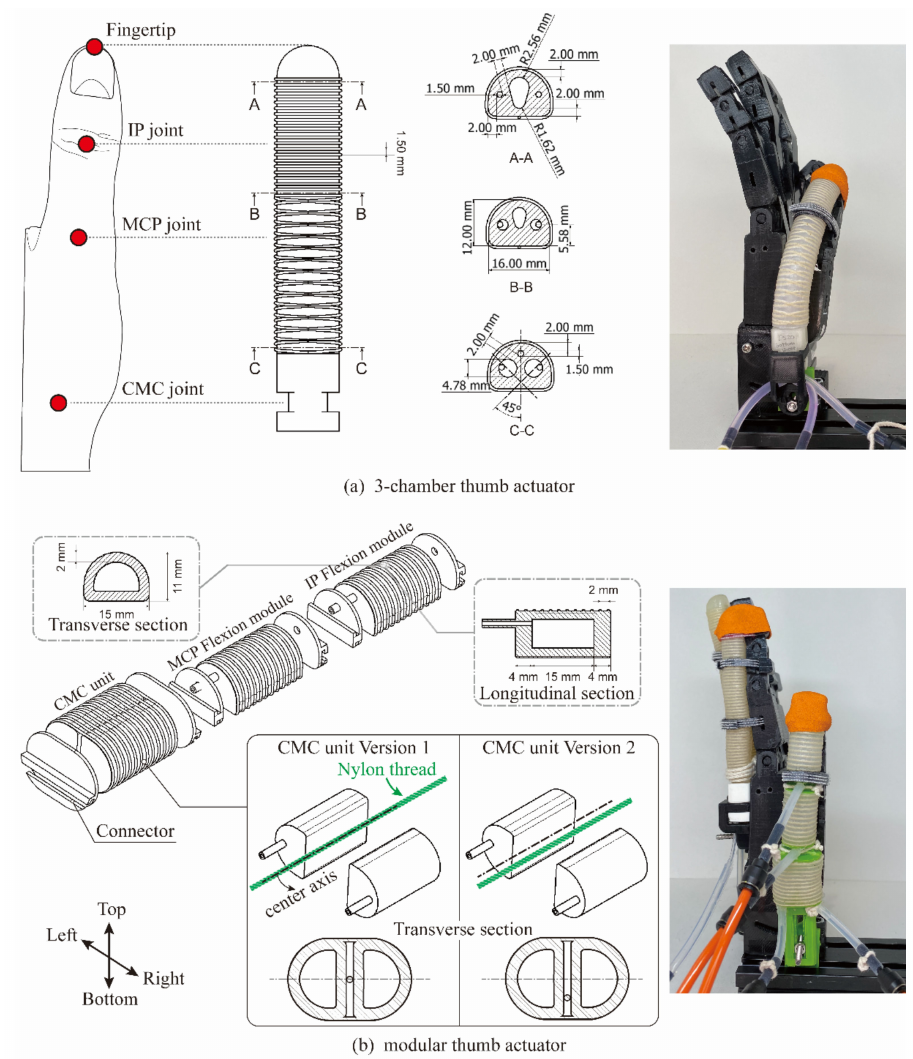
Figure 1. Actuator